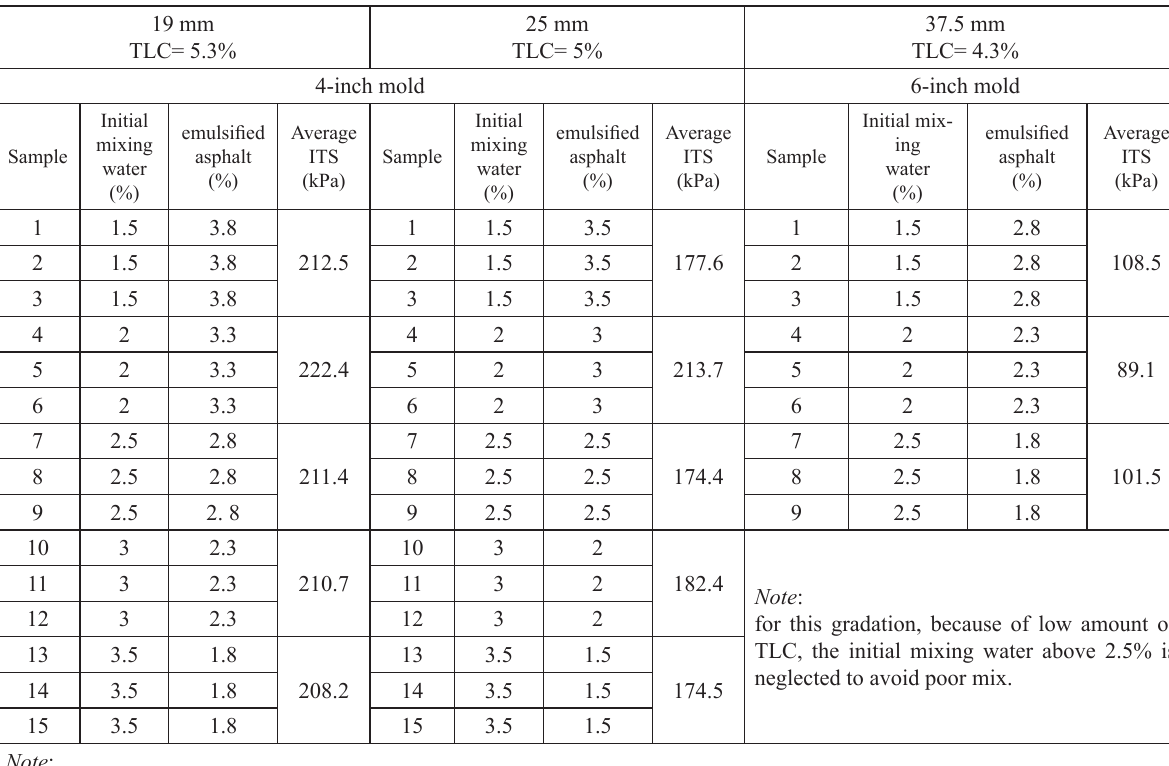
Table 3. Indirect tensile strength of 19, 25 and 37.5 mm gradations in partial